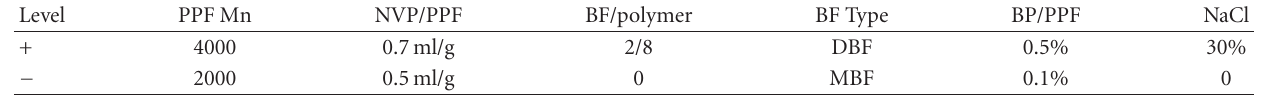
(a) High and Low Levels for Six Parameters Tested in a Resolution III, Two-level Fractional Factorial